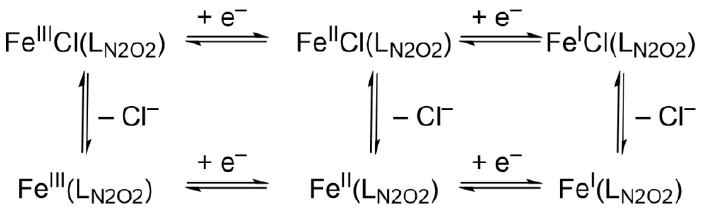
Figure 3. Redox equilibria of iron complexes. As previously observed for Fe (salophen)Cl [12], the loss of Cl − should be considered relevant at the level of the Fe I state under the conditions of the CV scans, in the absence of additional Cl − sources. Table 1. Electrochemical and spectroscopic characterization of iron complexes employed in this work.